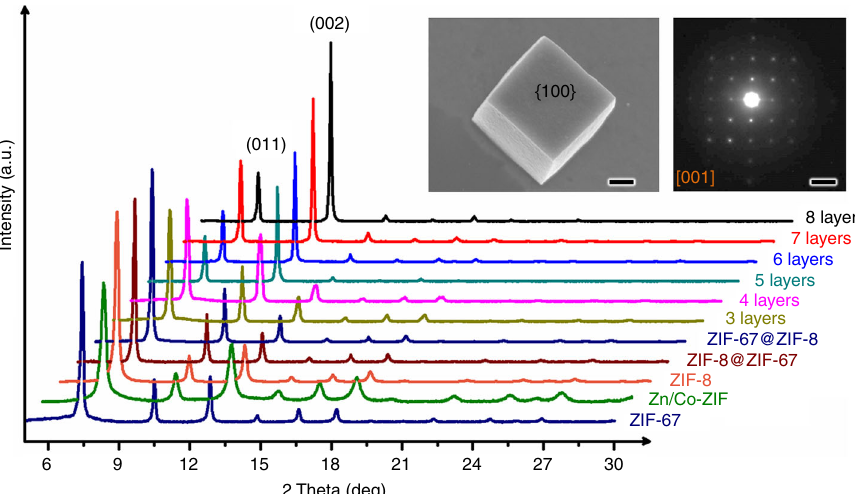
Fig. 4 XRD patterns of ZIF-67, ZIF-8, Zn/Co-ZIF, and nano-Matryoshka structured ZIFs. Inset is a SEM image of octa-layered ZIFs (scale bar, 500 nm) and a SAED pattern of the cubic ZIF-67 (scale bar, 1 nm − 1 ). See the detailed explanation of SAED information in Supplementary Fig. 15